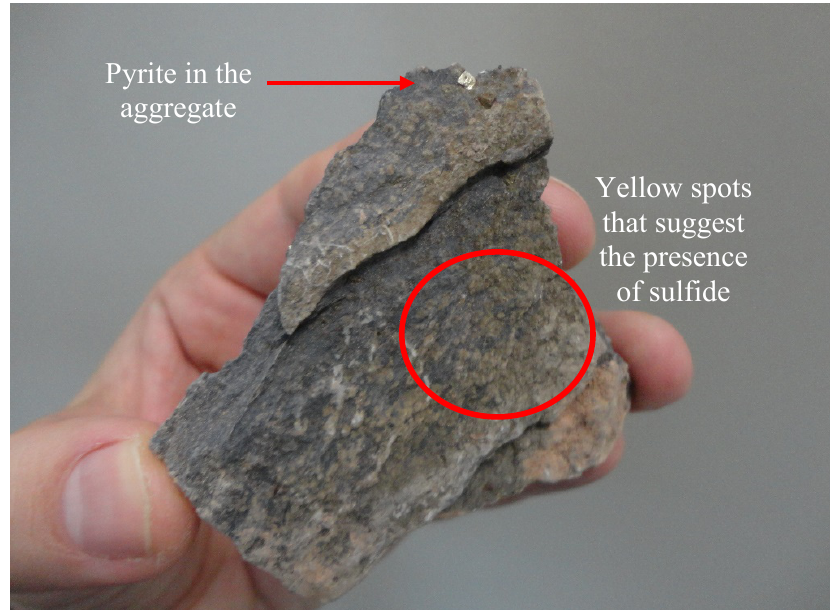
Figure 1. Example of Brazilian civil construction aggregate with verified pyrite contamination and generation of internal sulphatic